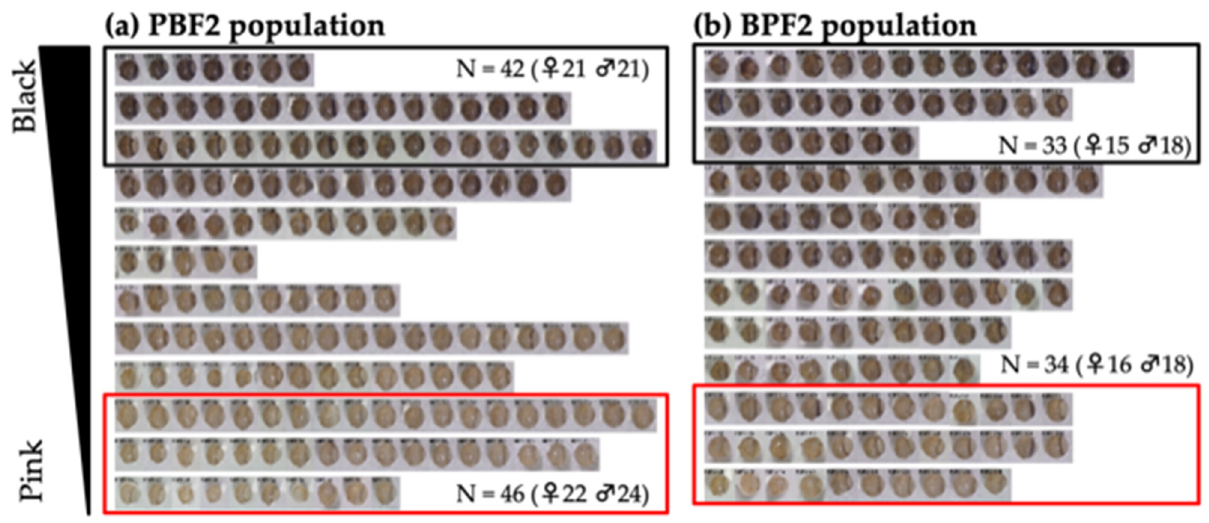
Figure 2. Distribution of eye color in F2 mice at 4 months of age: ( a ) 164 mice in the PBF2 population obtained from an intercross between a PINK female and a BLACK male; ( b ) 139 mice in the BPF2 population obtained from an intercross between a BLACK female and a PINK male. Approximately 25% of the mice with the darkest eye color surrounded by a black border and the lightest eye color surrounded by a red border were selected from each F2 population. N indicates the number of mice